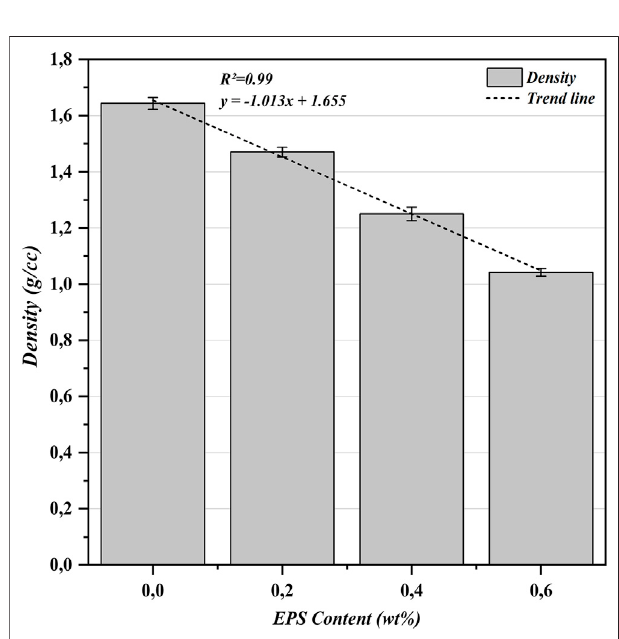
FIGURE 3 | Flash method setup.